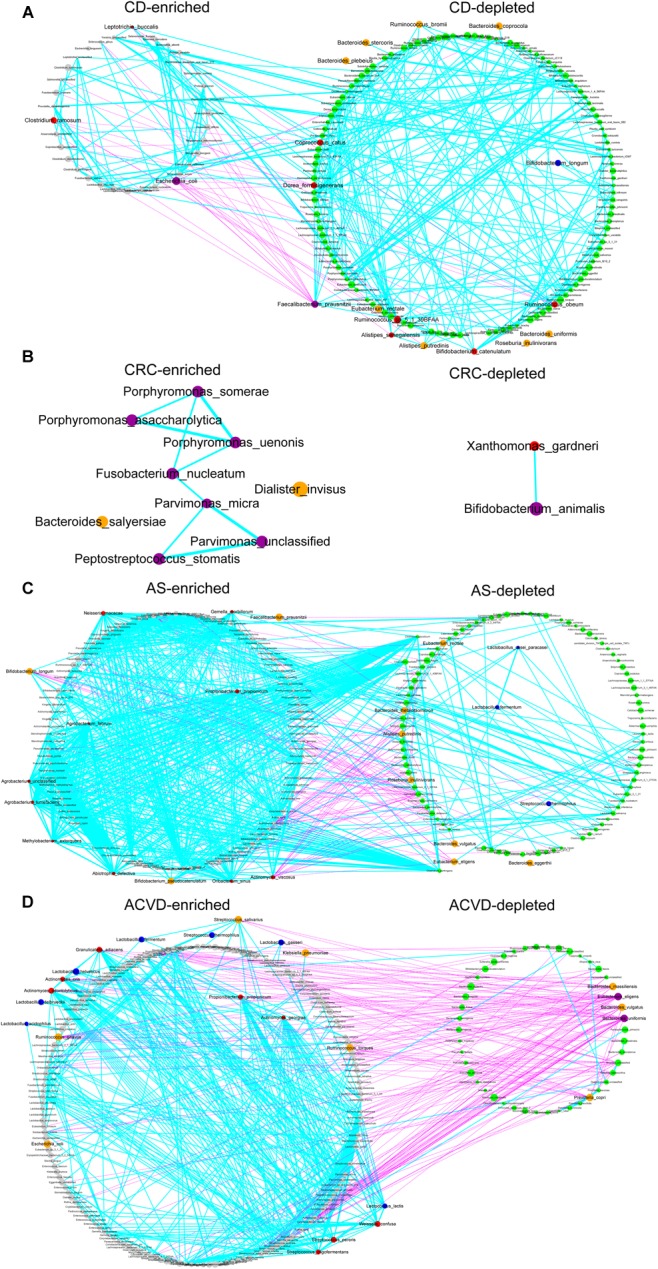
Traditional probiotics roles in the cohort gut microbiome. (A) The cohort of CD. (B) The cohort of CRC. (C) The cohort of AS. (D) The cohort of ACVD. Co-abundance network of species significantly enriched in case or control subjects. Left, network in individuals with disease (case-enriched); right, network in controls (case-depleted). Species with significantly different relative abundances between the groups are displayed (q-value <0.05, FDR-controlled Wilcoxon rank-sum test). Gray circles, case-enriched; green circles, control-enriched; purple circles, species with top 10 edges and top 10 abundance; red circles, species with top 10 edges; orange circles, species with top 10 abundance; blue circles, MTPS. The size of each circle indicates the mean relative abundance of species (1/10, 1/100, …, 1/10∗∗6, <1/10∗∗6). Please see Supplementary Table S5 for more detailed information on enriched or depleted species. Cyan edges means positive correlations; pink edges means negative correlations. The edge width declines along the absolute value of the Pearson cc: thick edges, |cc| >=0.7; medium, 0.4 <=|cc| <0.7; thin, 0.1 < |cc| < 0.4.